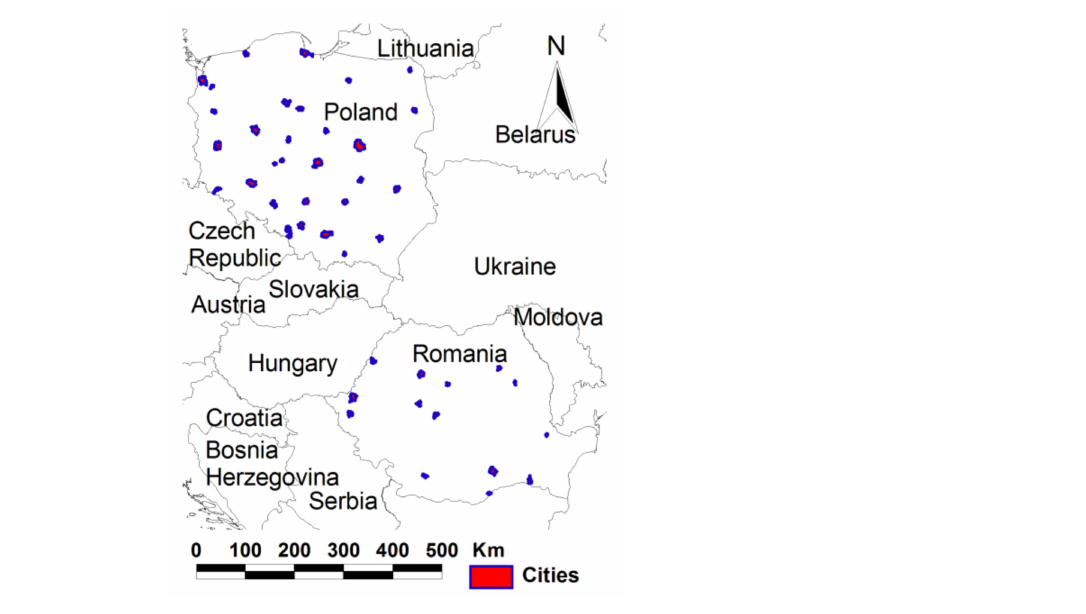
Figure 1. Cities included in the study. The size of the cities was enlarged for a better visualization of their